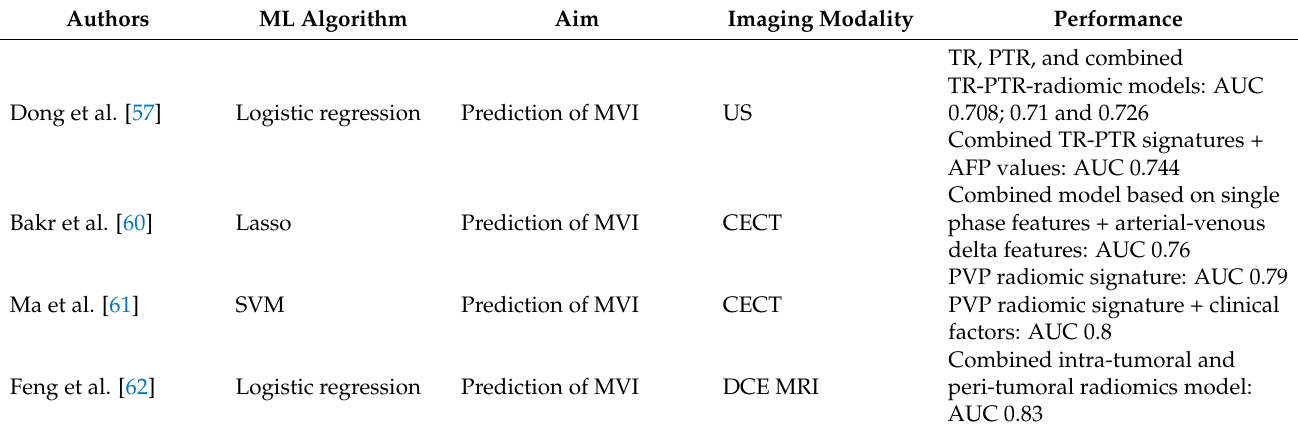
Table 4. Overview of ML algorithms applied to microvascular invasion